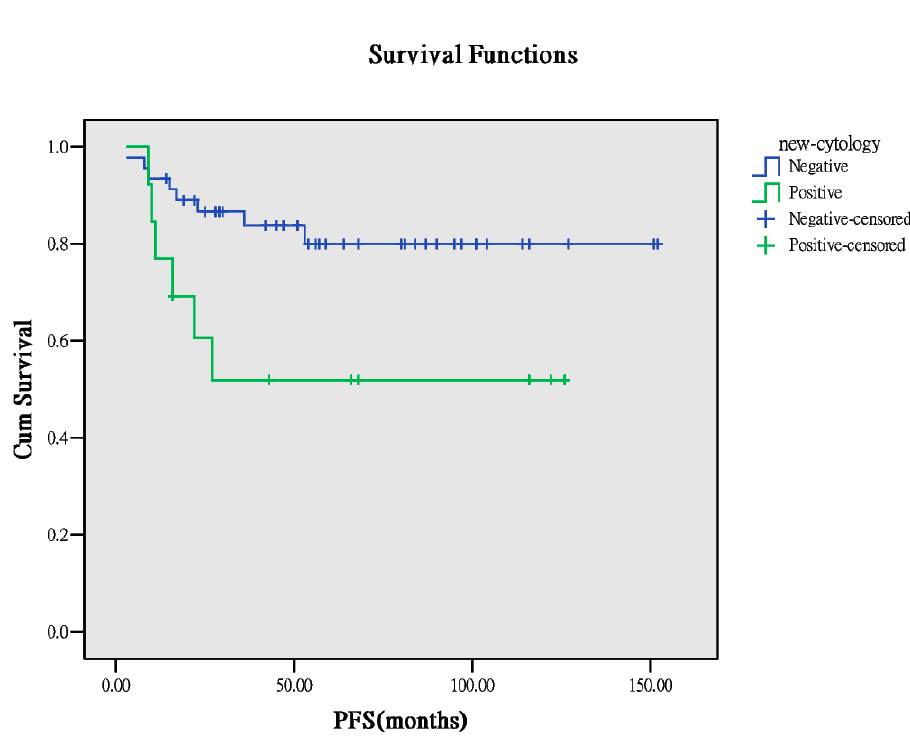
Figure 5. PFS between the cytology results ( p = 0.026).